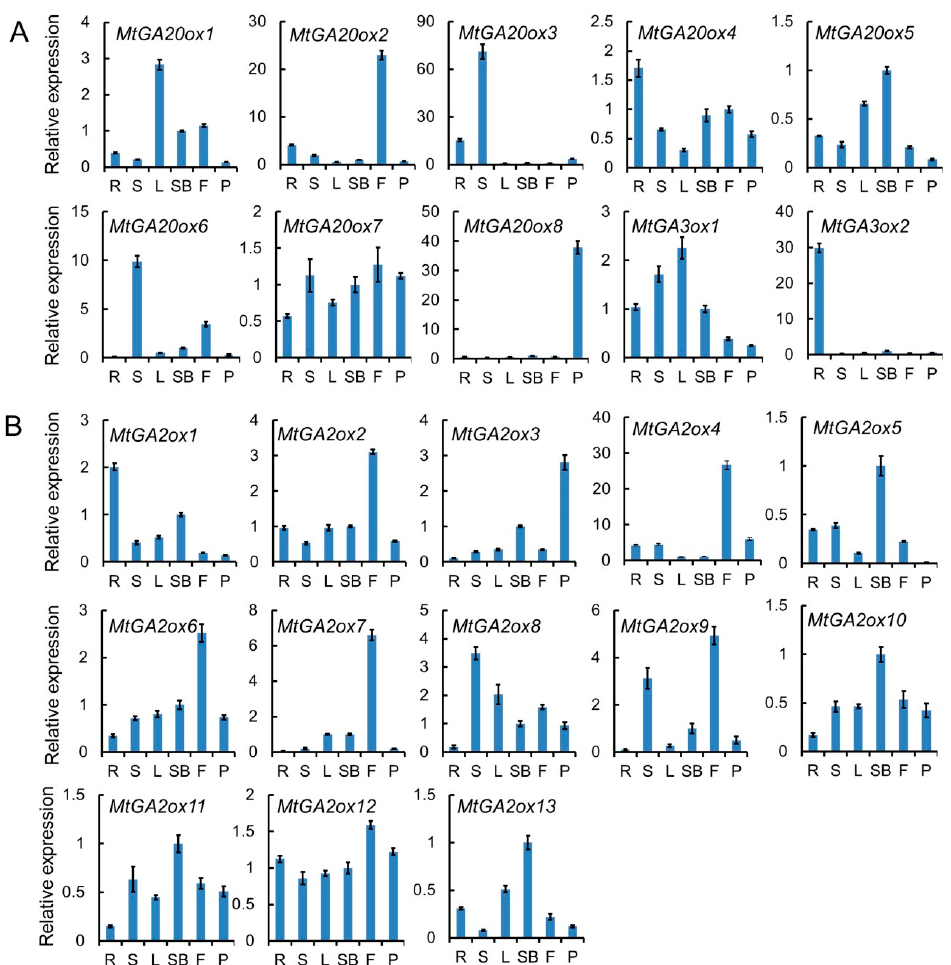
Figure 3. The expression patterns of MtGA20ox , MtGA3ox , and MtGA2ox genes in M. truncatula . ( A ) Expression analysis of gibberellin biosynthesis genes MtGA20ox and MtGA3ox in different tissues. ( B ) Expression analysis of gibberellin deactivation genes MtGA2ox in different tissues. R, roots; S, stems; L, leaves; SB, shoot buds; F, flowers; P, pods. The level of expression was normalized to M. truncatula UBI gene. Error bars represent SD for three biological replicates. 2.5. Identification of GA Receptor MtGID1 and MtDELLA Genes in M. truncatula